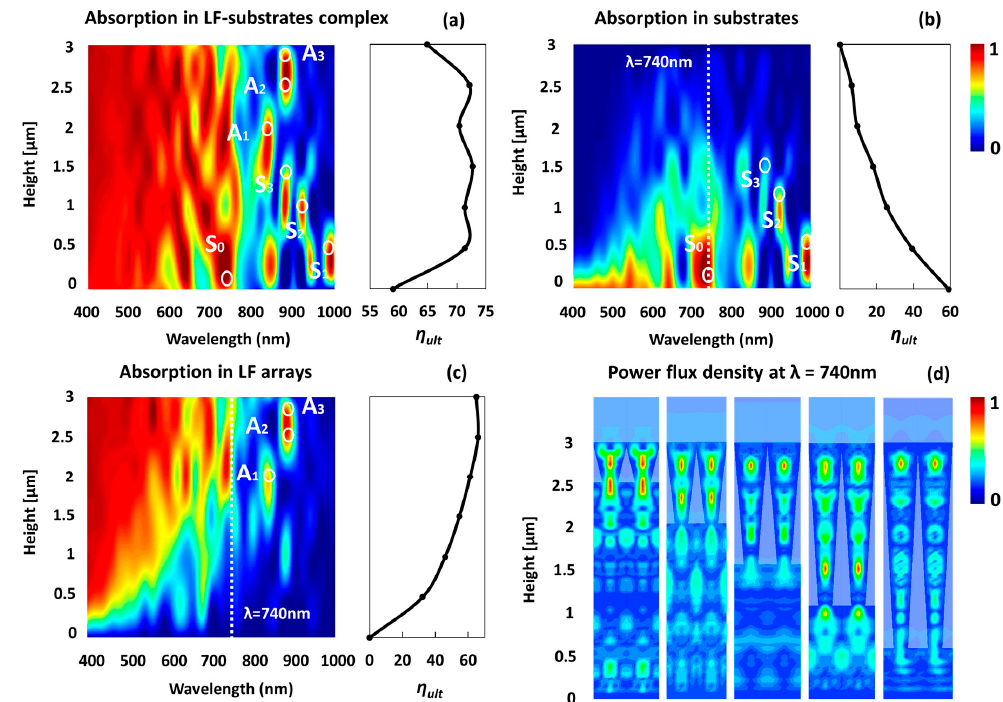
Figure 2. ( a ) The relative absorption of the LF array ‐ substrate complex for the various geometries. The respective η ult are shown on the right. ( b ) The relative absorption of the substrate component of the LF array ‐ substrate complex for the various geometries. The respective η ult of the substrates are shown on the right. The color-coded scale bar in Figure 1b is for Figure 2a–c. ( c ) The relative absorption of the LF array component of the complex for the various geometries. The respective η ult of the LF arrays are shown on the right. ( d ) The normalized power flux density at wavelength 740 nm. Note the various optical excitations in the substrates as well as the LFs the near-field light concentration into the substrates. The cross-sections are normal to the plan of